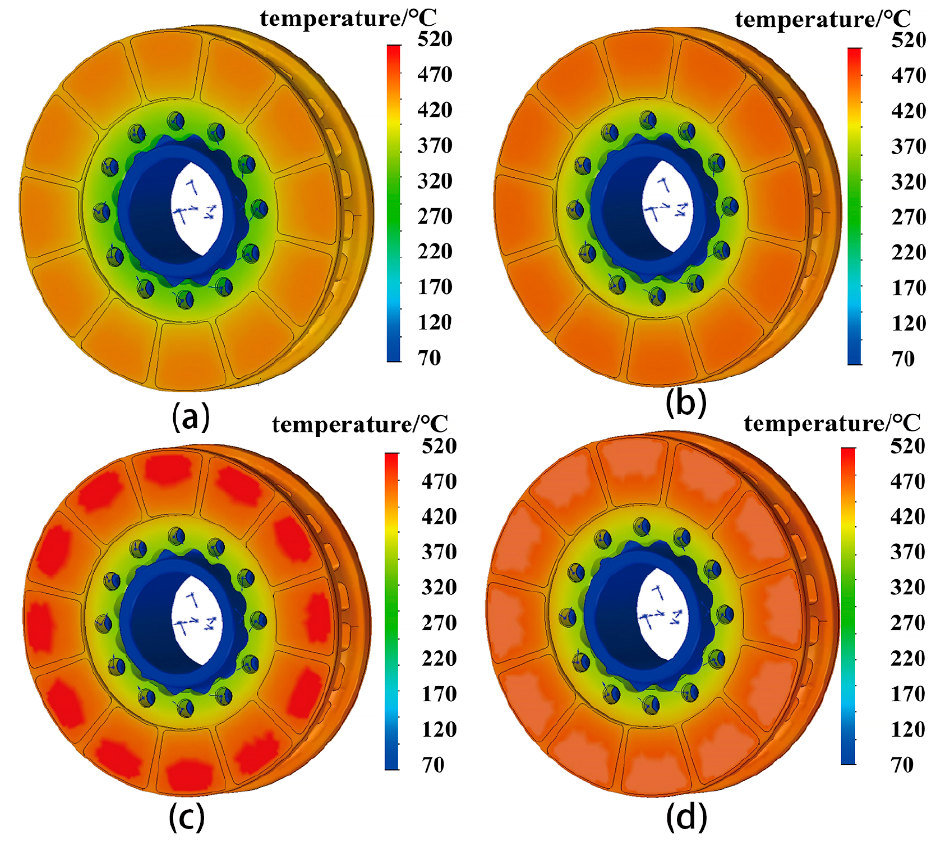
Figure 12. Temperature distribution of the brake disc at different stages of braking operation (IBV = 97 m/s, thickness of wear-resisting layer = 4 mm): ( a ) 12 s; ( b ) 30 s; ( c ) 63 s; ( d ) 83 s.